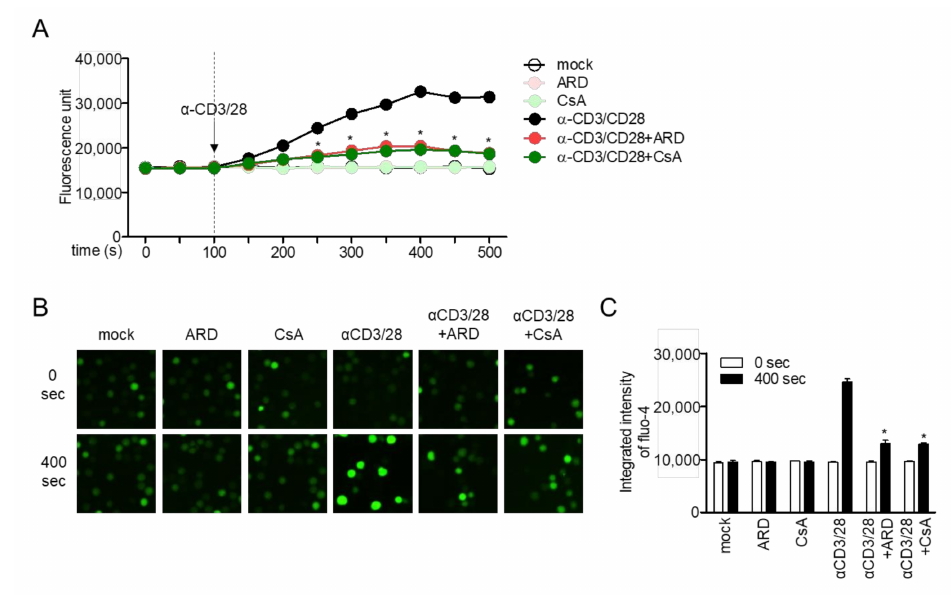
Figure 5. Aromadendrin inhibits Ca 2 + mobilization in activated T cells. Stained Jurkat T cells with 4 µ M fluo-4 were pre-treated with 40 µ M aromadendrin or 2.5 µ M CsA for 1 h, and soluble anti-CD3 / CD28 antibodies were added to the cells for stimulation at 100 s. ( A ) Increased Ca 2 + influx was assessed by an Immunoabsorbance reader and ( B ) IncuCyte. ( C ) The mean value ± SEM of integrated intensity of fluo-4 are presented in the bar graph. * p < 0.05, versus the cells activated by anti-CD3 / CD28